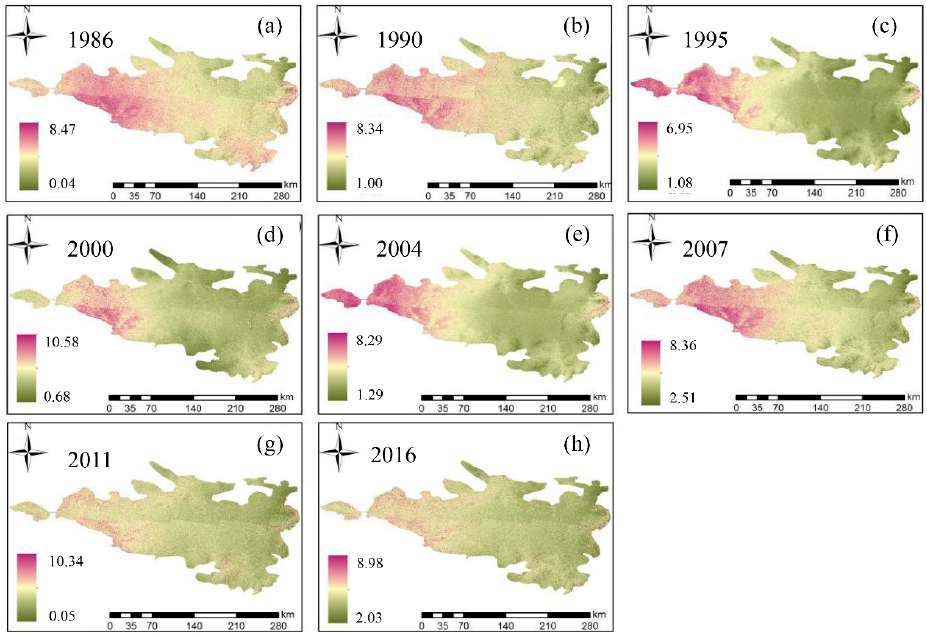
Figure A2. Spatial ‐ temporal distribution of annual mean temperature from 1986 to 2016. Figure A2. Spatial-temporal distribution of annual mean temperature from 1986 to